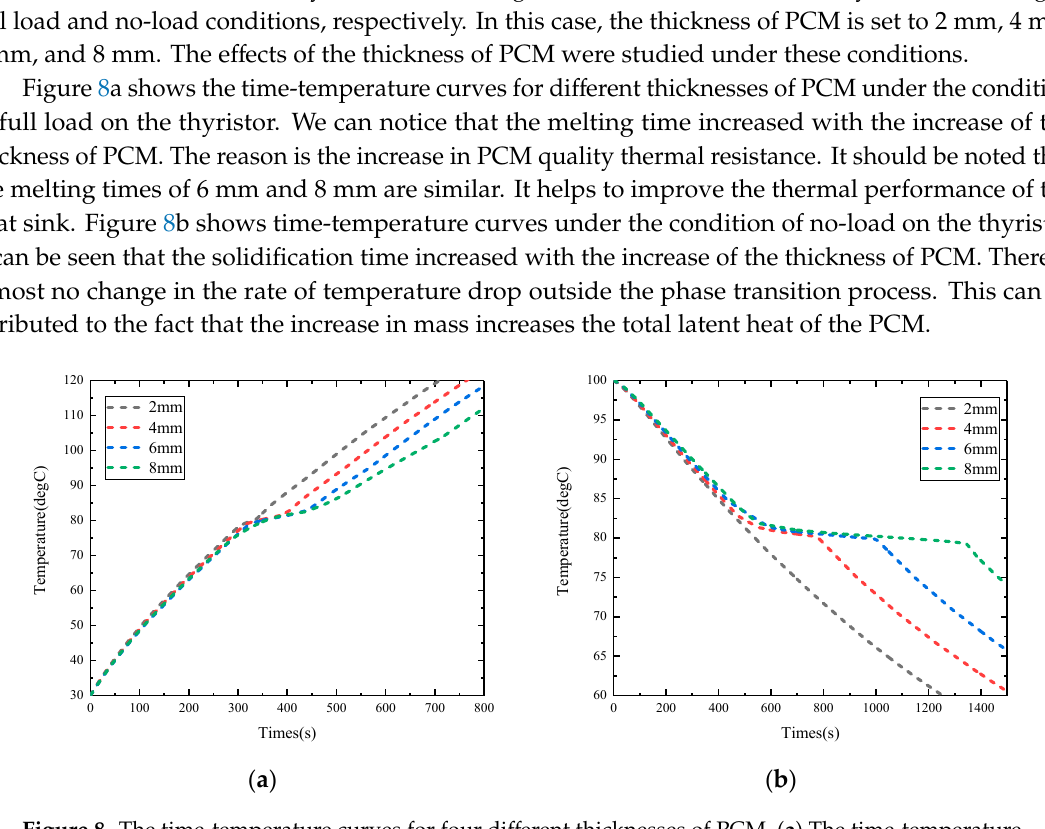
Figure 8. The time-temperature curves for four different thicknesses of PCM. ( a ) The time-temperature curves under full load conditions; ( b ) The time-temperature curves under no-load conditions.